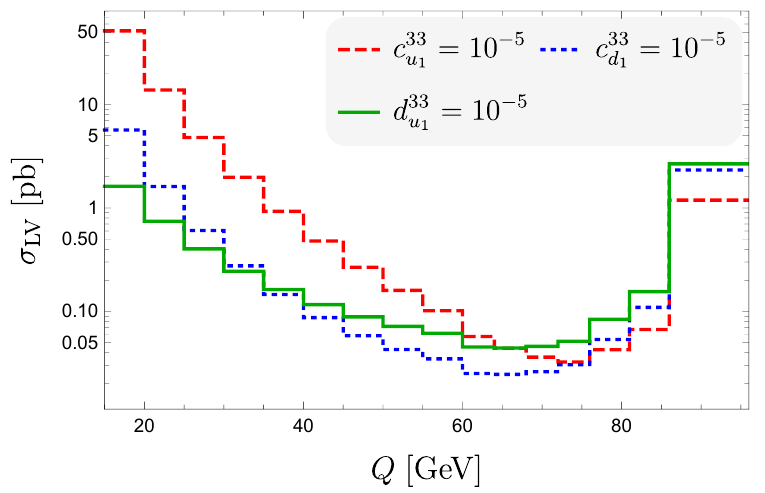
Figure 1 . An illustration of the Lorentz-violating contributions σ LV from eq. (3.14) in the collider frame for select coefficients fixed to magnitudes of 10 − 5